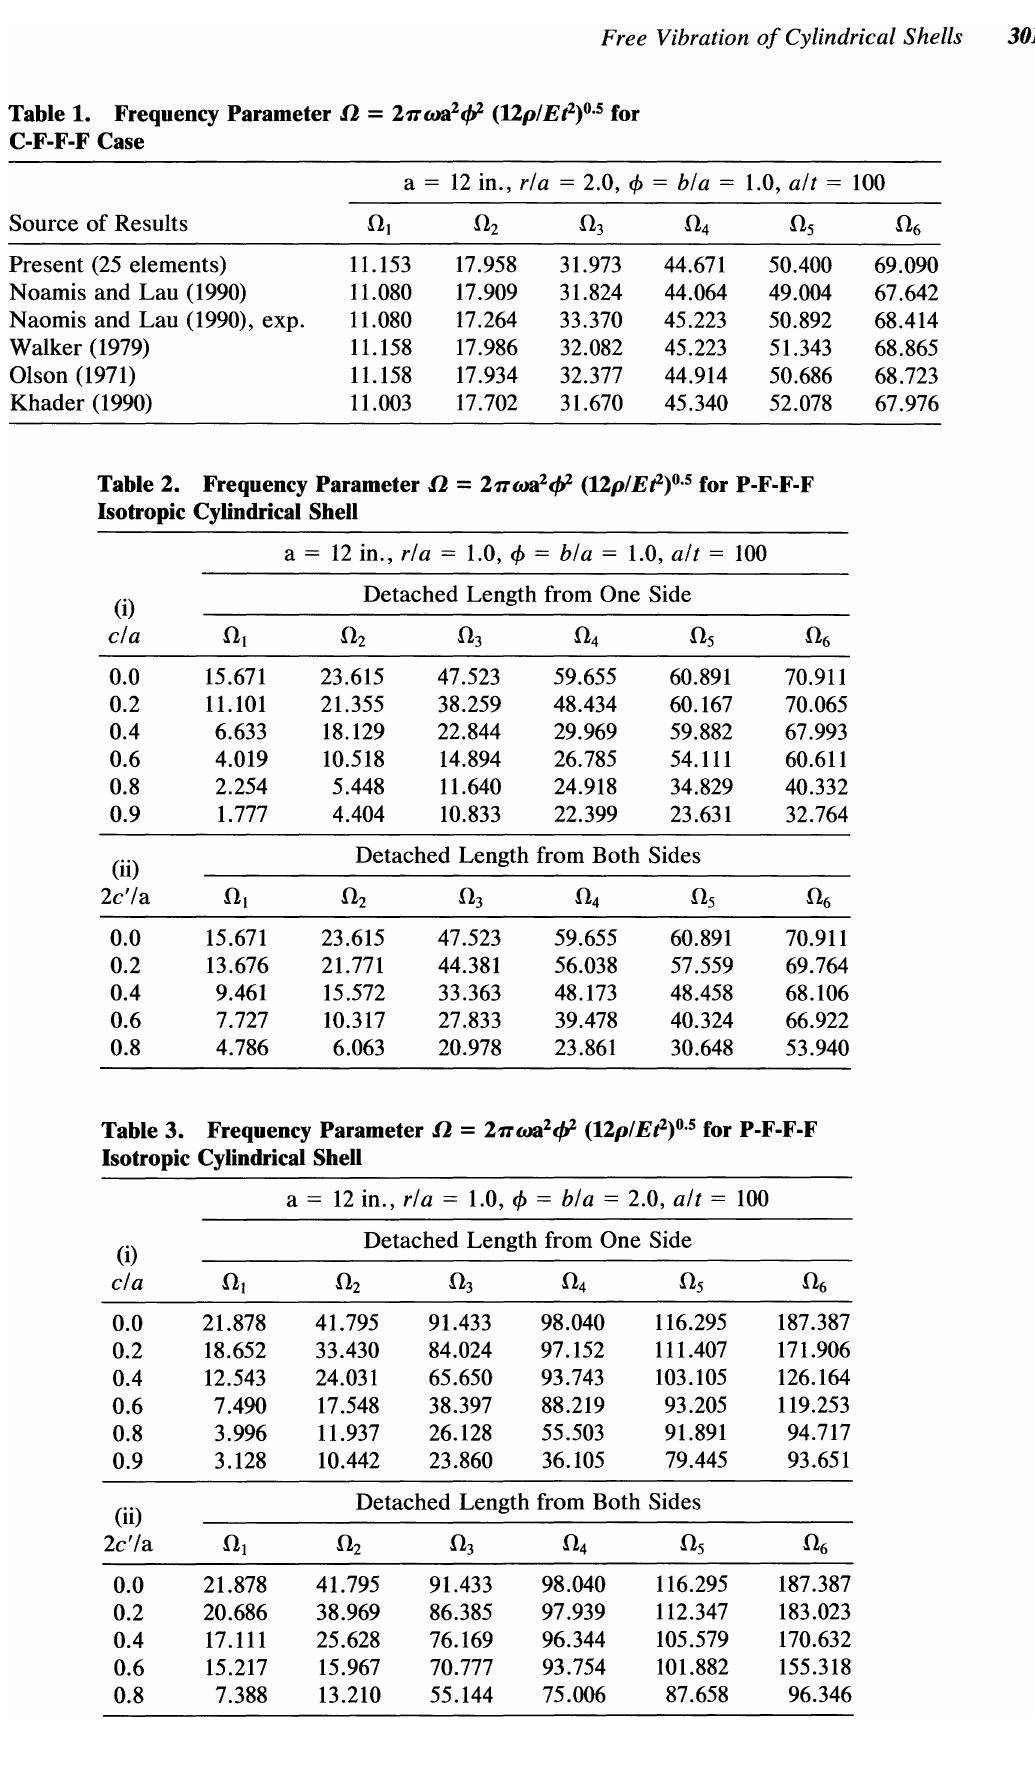
n = 21Twa 2 rJ} (UpIEr)o.s for